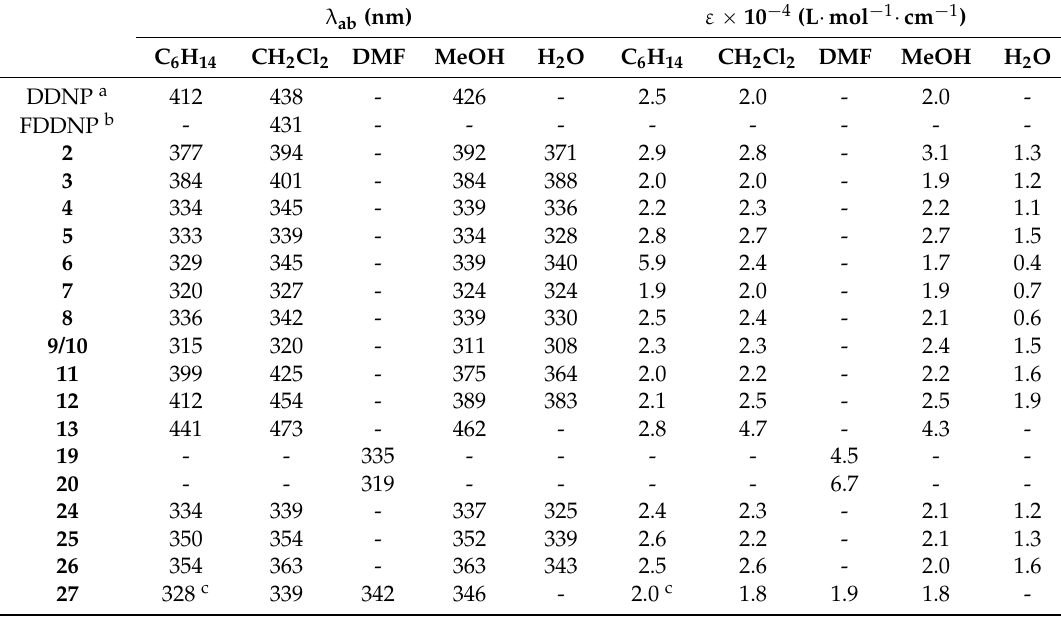
Table 1. Selected UV/vis maxima and molar absorption coefficients of FDDNP, DDNP, and